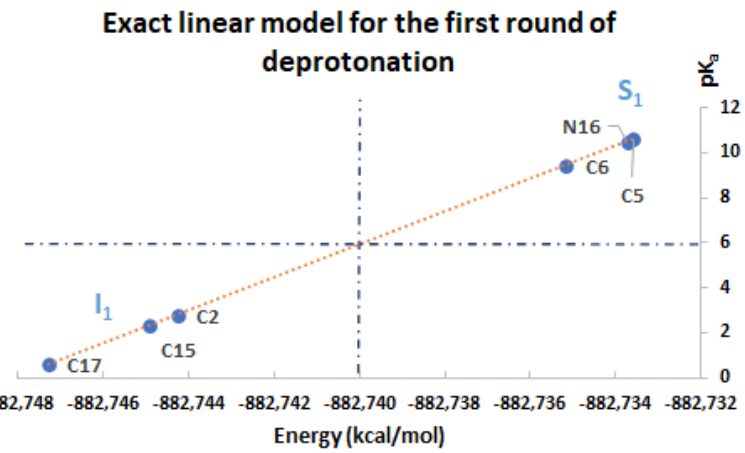
Figure 12. pK a calculation used a direct approach for the first round of deprotonation. Two subclus- ters are formed: I 1 with C2, C15, and C17; S 1 with C5, C6, and N16.